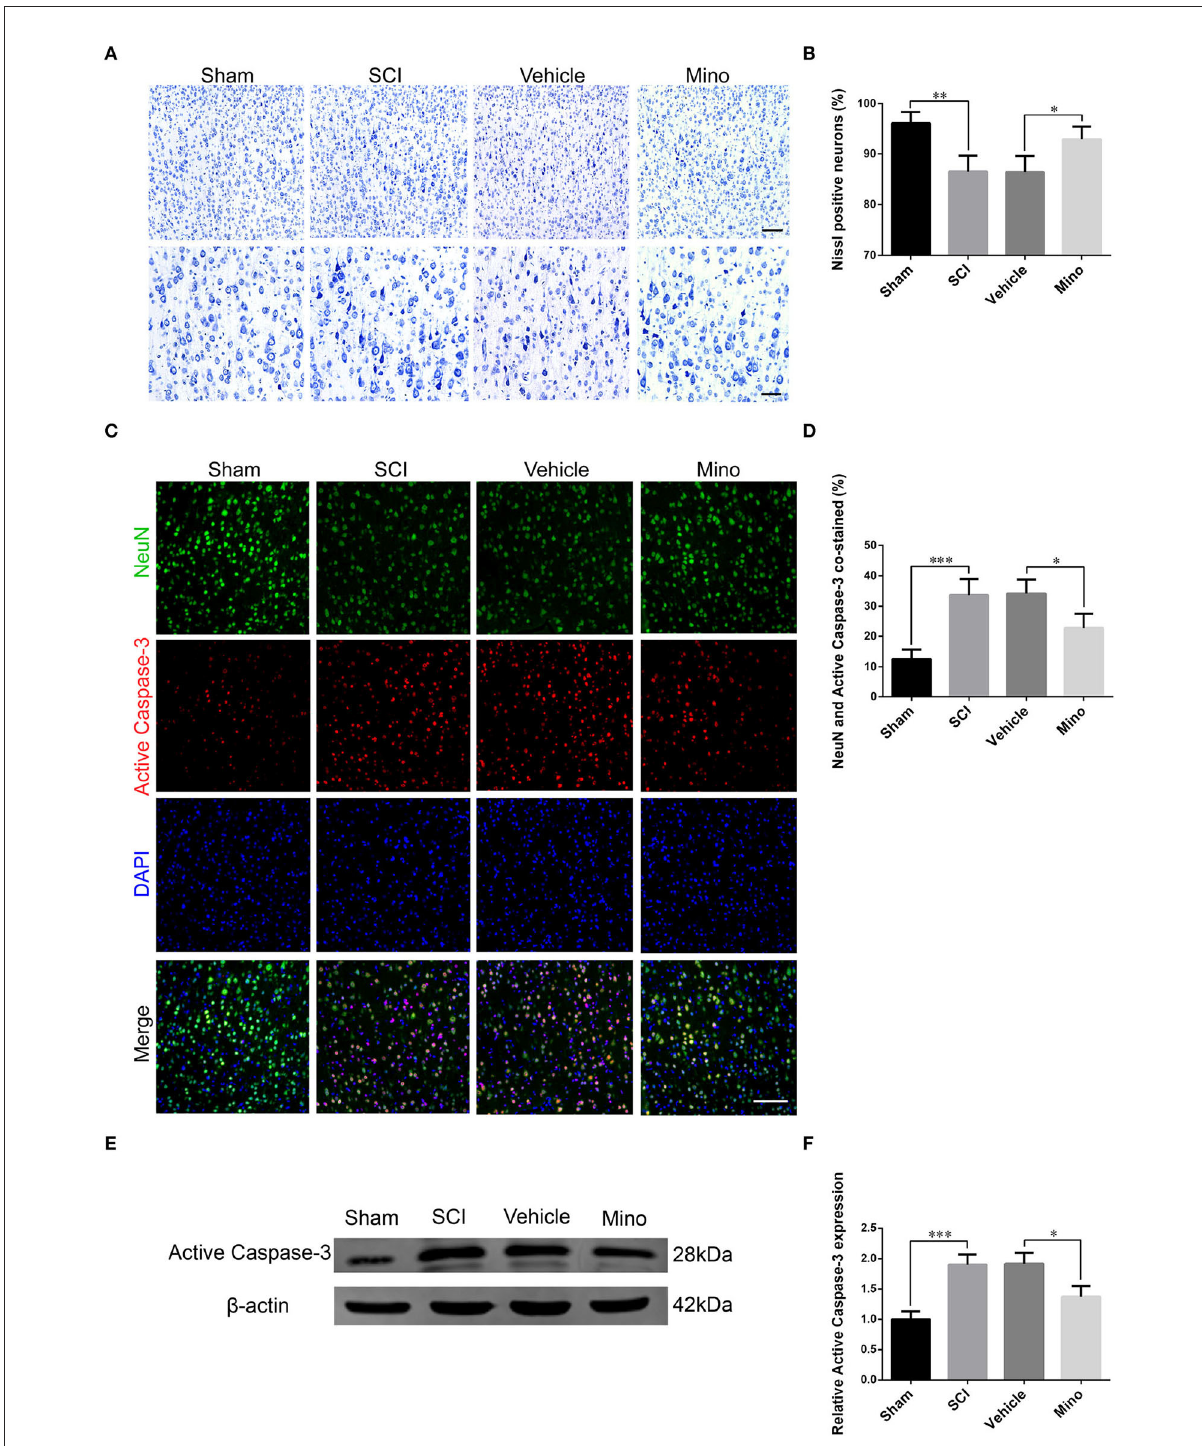
FIGURE3 Neurons in M1 were damaged after SCI, an effect that was reversed by minocycline therapy. (A) Representative images of Nissl staining and (B) quantitative analysis of Nissl-positive neurons in M1 of each group. Scale bars = 100 (upper panels) and 50 µ m (lower panels). (C) Representative immunofluorescence images and (D) quantitative analyses of NeuN and cleaved caspase-3 co-staining in M1 in each group. Scale bars = 100 µ m. (E) Representative immunoblots and (F) quantitative analyses of cleaved caspase-3 expression in M1 of each group (data were presented as means ± SD, n = 4 for Nissl staining and immunofluorescent, n = 3 for WB, * p < 0.05, ** p < 0.01, *** p <